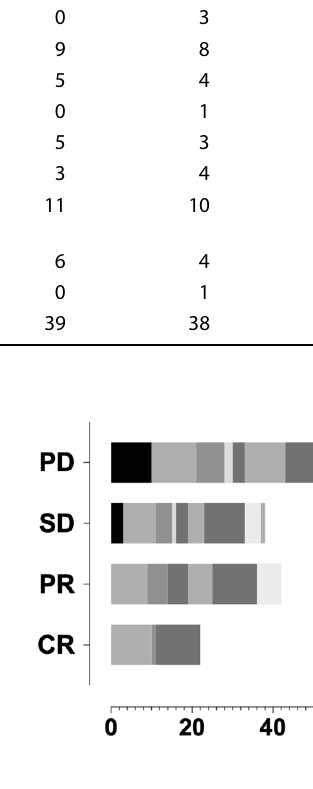
Table 3 Short-term efficacy evaluation